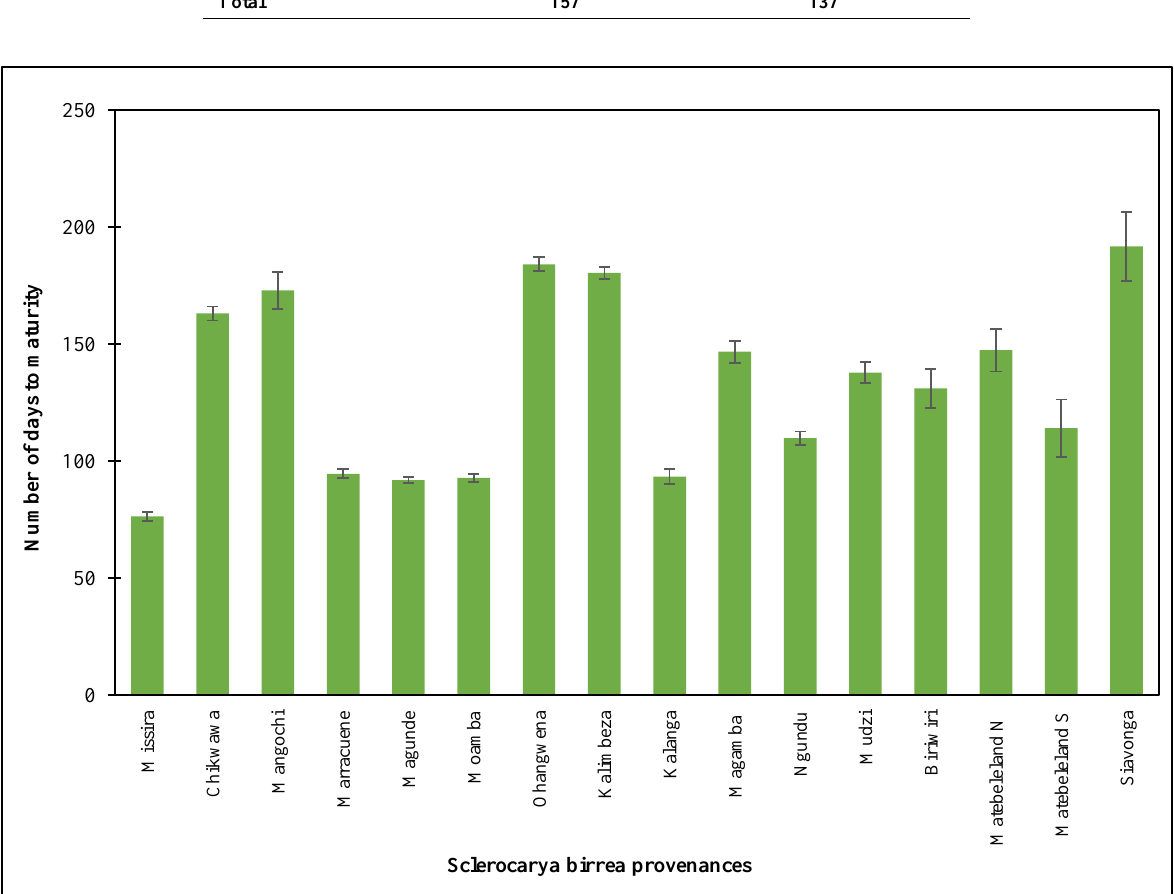
Figure 4. Fruit maturity period (onset – maturity) for sixteen provenances of S. birrea that had